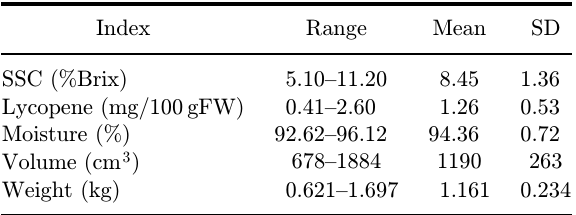
Table 1. Statistics of chemical and physical parameters of 94 watermelon